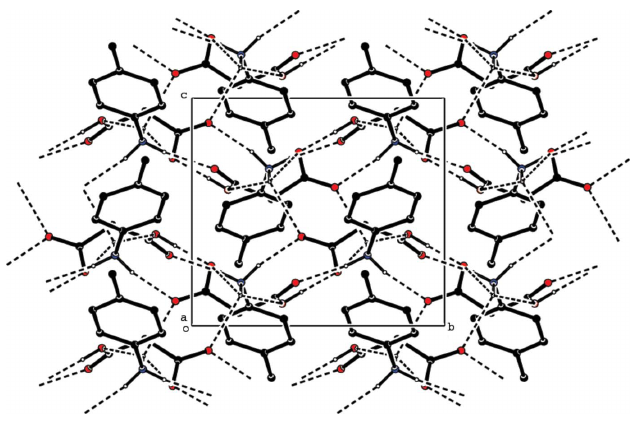
Figure 2 The crystal packing of the title molecular salt viewed along the a axis. The hydrogen bonds are shown as dashed lines. H atoms not involved in hydrogen bonding have been omitted for